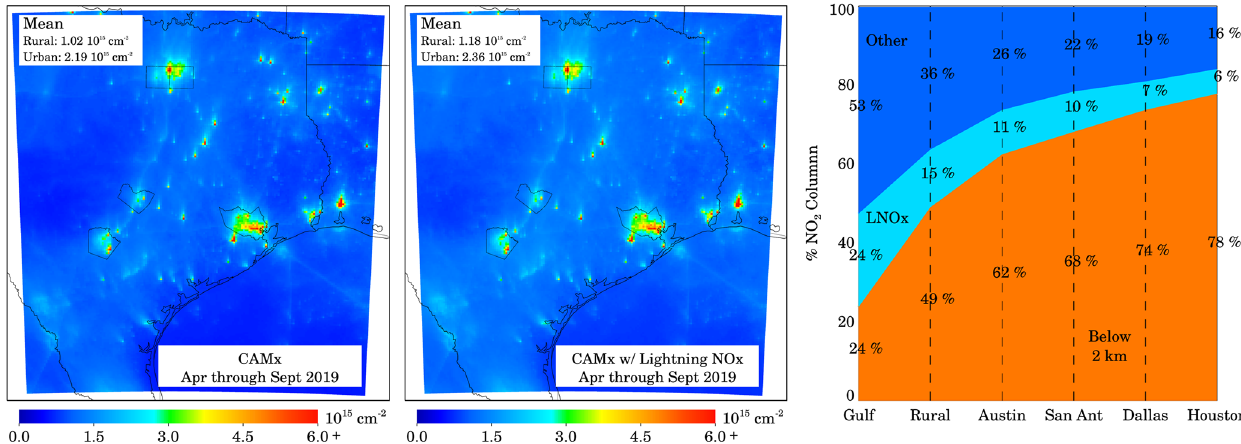
Figure 4. NO 2 tropospheric vertical column amounts from the CAMx model (left panel) without and (center panel) with lightning NO x emissions averaged during April through September 2019 at the coincident TROPOMI overpass time ( ∼ 19:00UTC). Areas with invalid TROPOMI data are similarly screened out from the model output on a daily basis. The urban area is defined as the five counties surrounding the largest five cities (Houston, Dallas, Fort Worth, San Antonio, and Austin). The rural area is everywhere outside those counties. The right panel shows the fraction of the NO 2 column attributed to different layers of the atmosphere (below 2km, above 2km (attributed to Other), and above 2km attributed to lightning NO x (LNO x )) at six locations (Gulf of Mexico, rural central Texas, Austin, San Antonio, Dallas, and Houston). The fraction attributed to lightning NO x (LNO x ) is calculated as the NO 2 addition between the two simulations without and with lightning NO x